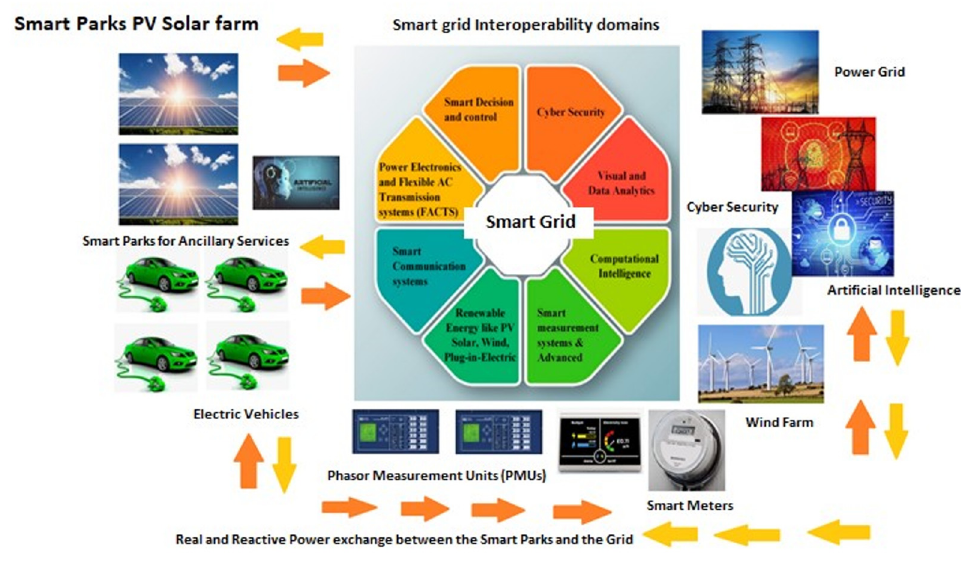
Figure 8. Smart grid conceptualization model.